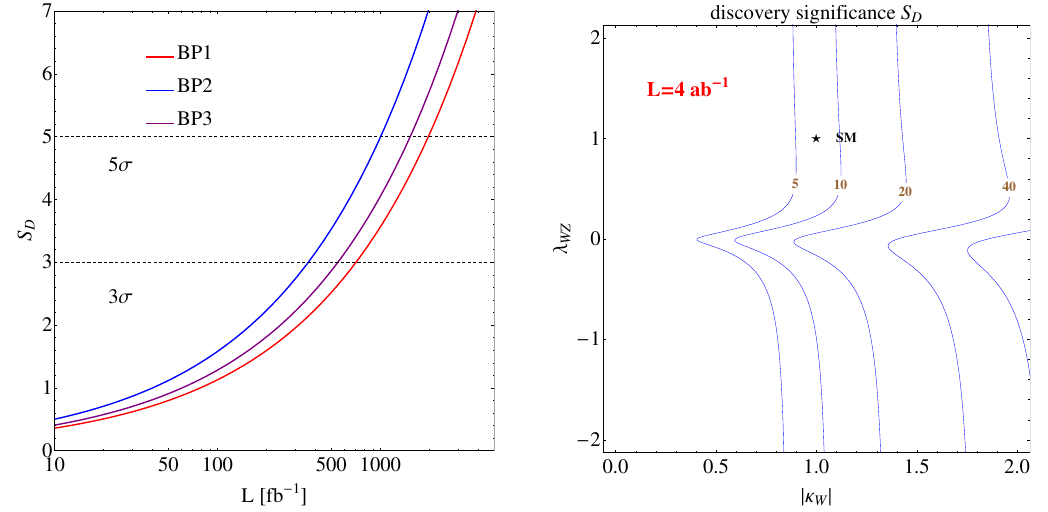
W + W (cid:0) H in the ‘ (cid:6) ‘ (cid:6) ‘ (cid:7) jj channel for scheme A at the ! 0 : 8 ; +0 : 3). Left: signal signi(cid:12)cance of the (cid:0)